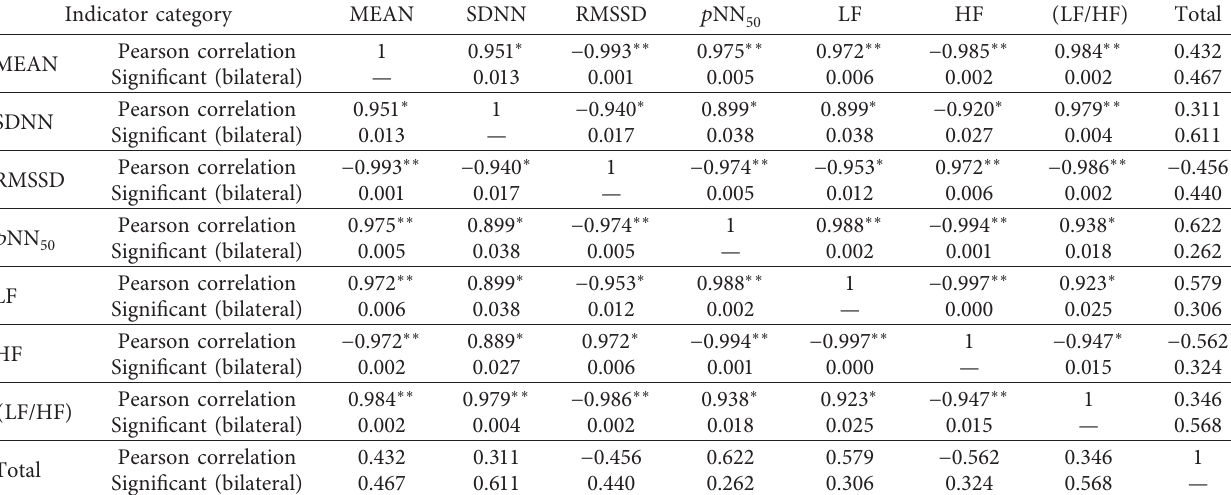
Table 6: Pearson correlation